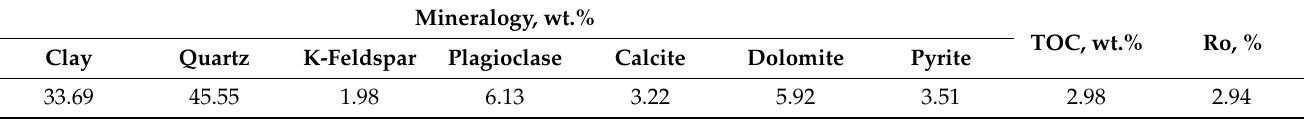
Table 1. The mineralogy, total organic carbon (TOC) and vitrinite reflectance (Ro) of shale samples. Mineralogy, wt.%